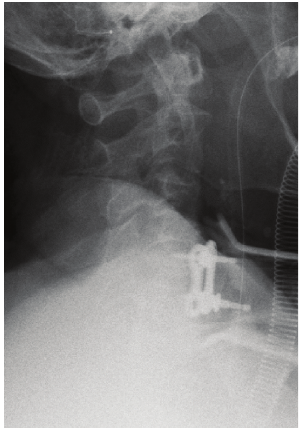
Figure 2: The first intraoperative radiogram after exposure of the vertebrae showing the needle inserted into the C4-5 disc.